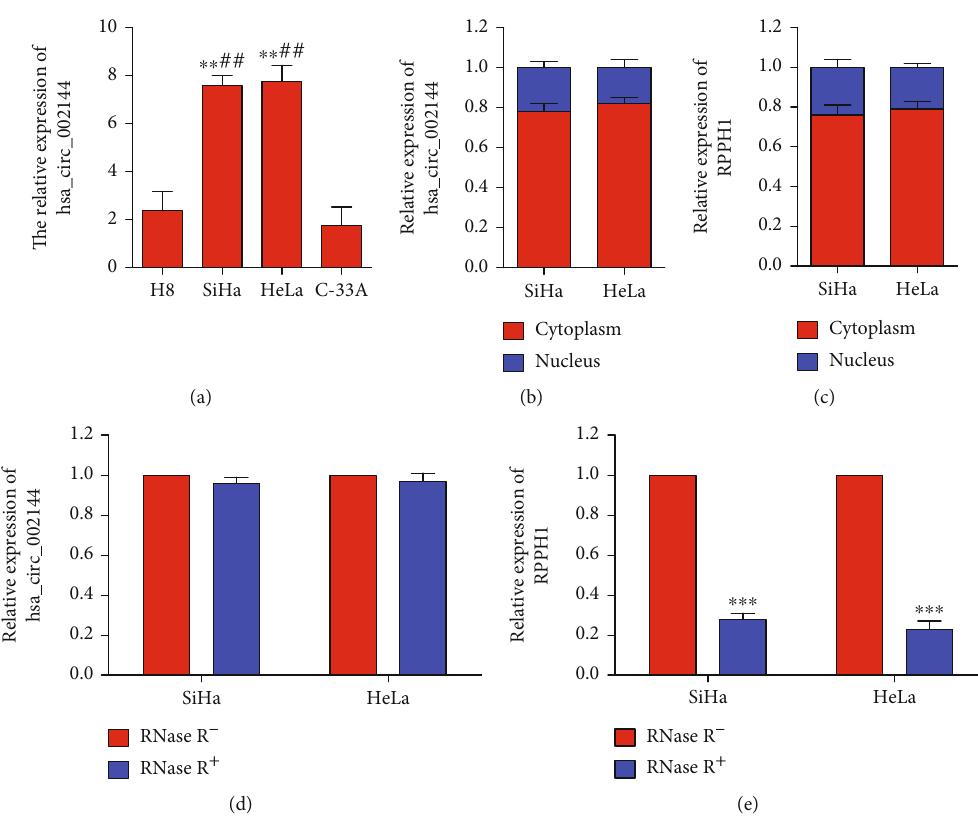
Figure 1: hsa_circ_0000511 was highly expressed in SiHa and HeLa cells and mainly located in the cytoplasm. The expression levels of hsa_ circ_0000511 in SiHa and HeLa cells were signi fi cantly higher than those in H8 and C-33A cells (a) ( mean ± SD ; the data were analyzed by one-way analysis of variance; vs. H8, ∗∗ p < 0 : 01 ; vs. C-33A, ## p < 0 : 01 ). hsa_circ_0000511 (b) and its gene symbol ( RPPH1 ) (c) were mainly expressed in the cytoplasm in SiHa and HeLa cells. hsa_circ_0000511 can be resistant to RNase R + (d), while RPPH1 is not (e) ( mean ± SD ; the data were analyzed by an unpaired two-sided t -test; ∗∗∗ p < 0 : 001